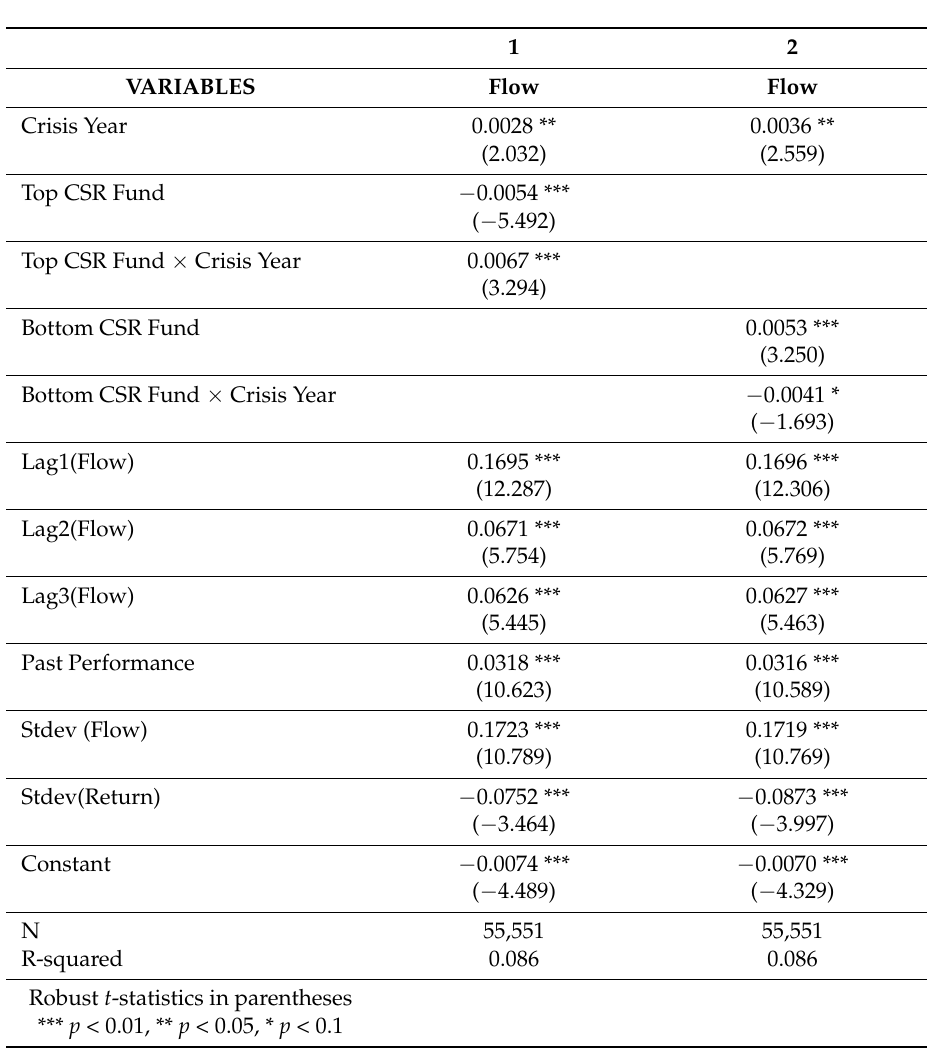
Table 11. CSR-funds and new investments: financial crisis versus non-crisis subsample analysis (controlling for return and flow